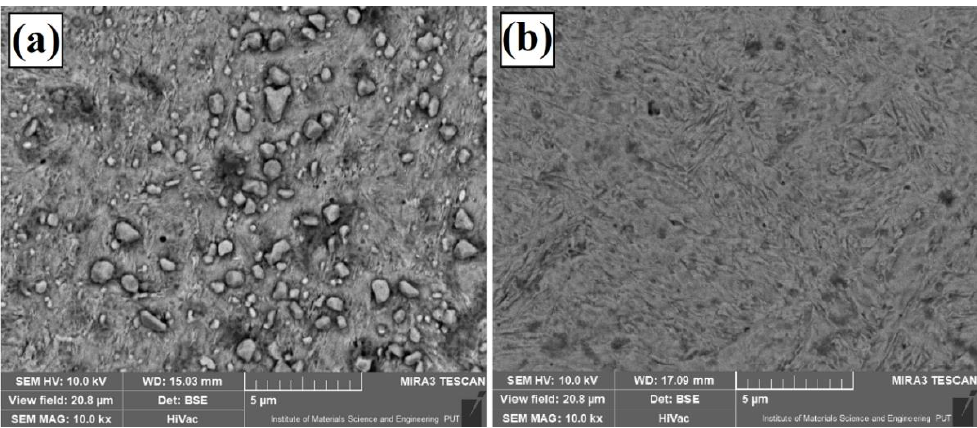
Figure 13. Image of surface condition after corrosion tests at large magnification (10,000 × ) for ( a ) W–Cr / 75% WC coating and ( b ) W–Cr